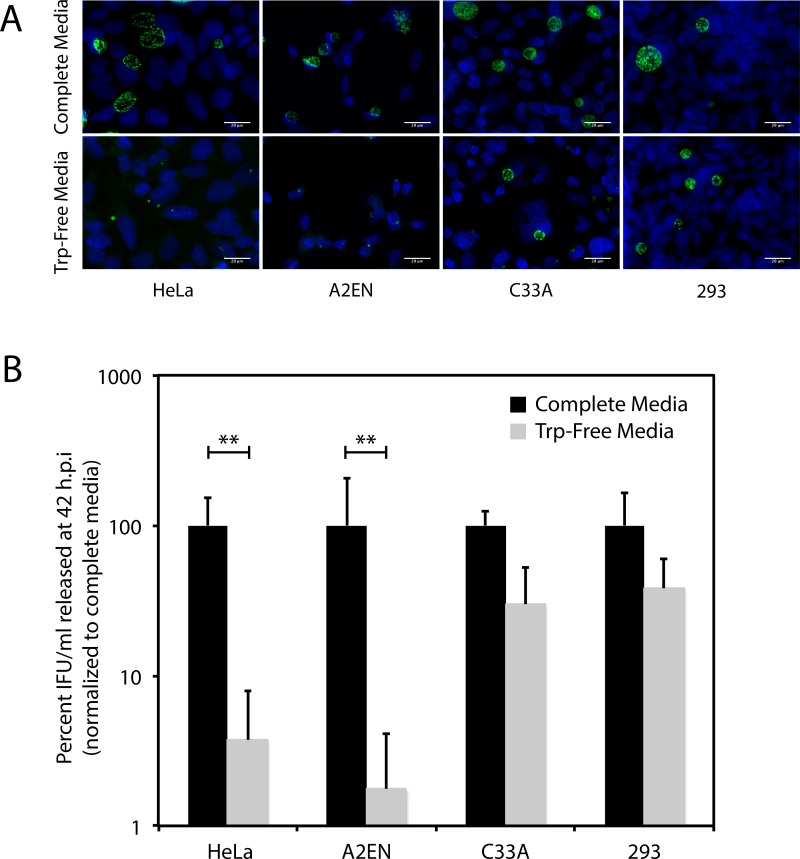
Cell-line dependent differences in the effect of tryptophan depletion on C. trachomatis development.Cells were infected with C. trachomatis at an m.o.i of 5 as described in the methods. After infection cells were maintained in complete media or tryptophan-free media. After 42 h.p.i. cells are either stained by immunofluorescence for chlamydial LPS using a FITC-conjugated antibody, or harvested to quantify IFU recovery by infection of HeLa cells. A) Chlamydial inclusions (green) formed in HeLa, A2EN, C33A and 293 cells 42 h.p.i. Cells were counterstained with Hoechst dye. Scale bar indicates 20 μm. B) IFU/mL recovered after 42 h.p.i. in HeLa, A2EN, C33A and 293 cells as evaluated by infection of HeLa cells. The bars represents mean and standard deviation from three independent experiments (** indicates P < 0.01 by the Wilcoxon rank sum test).